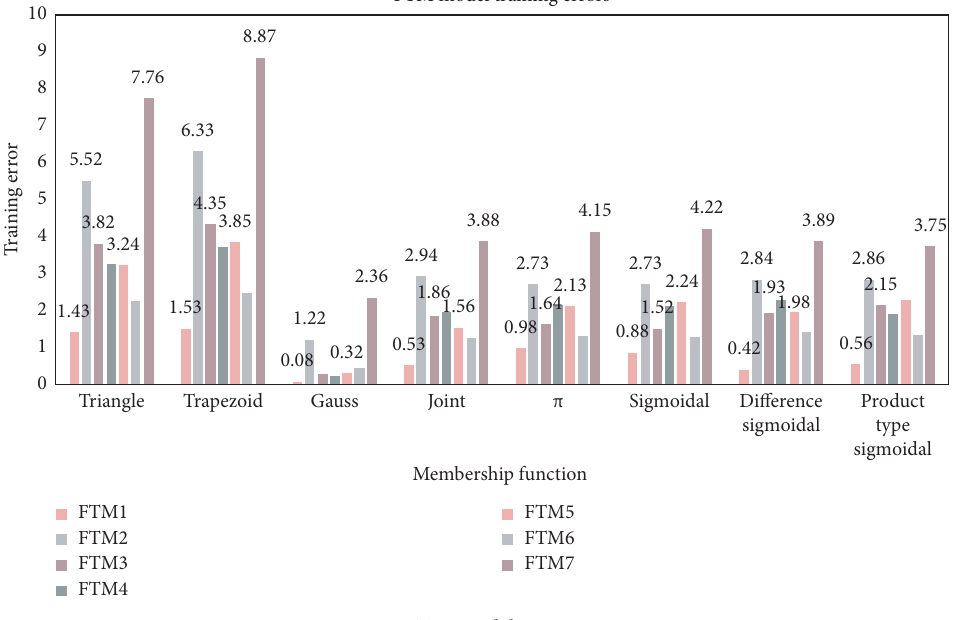
Figure 7: 7 FTM model training